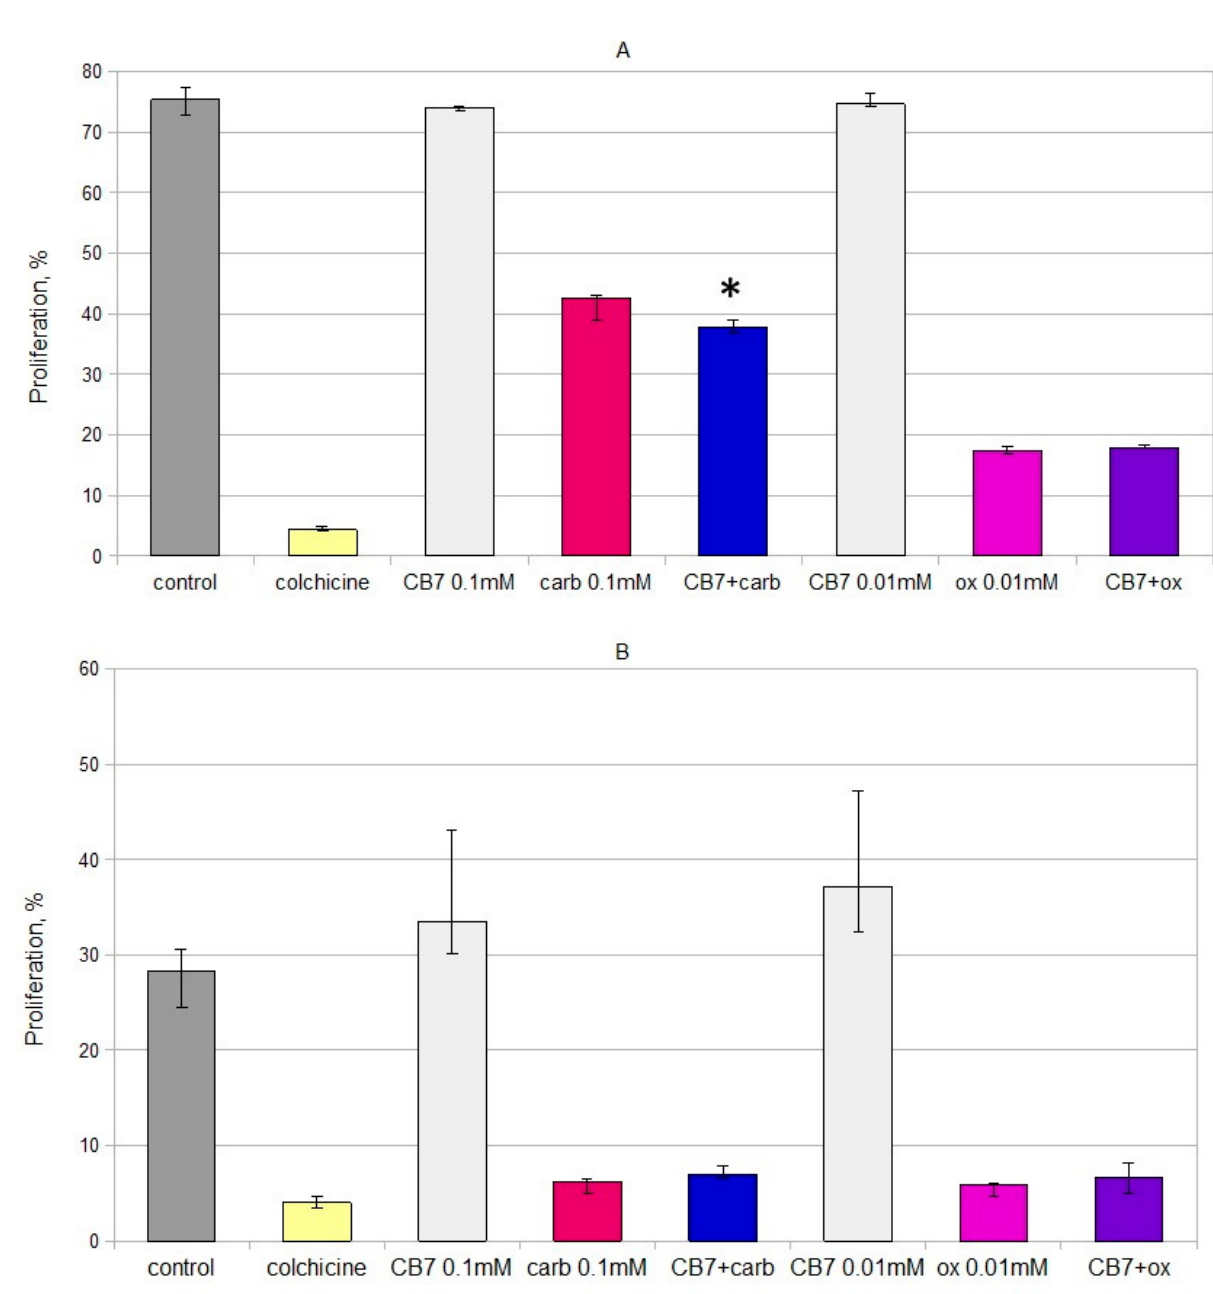
Figure 3. Effects of the CB[7] and platinum drugs on proliferation activity of different cell line. ( A ) Effects of the oxaliplatin–CB[7] complex and the mixture of CB7 and carboplatin (1:1) on proliferation of B16 cells. * Indicates a significant difference ( p < 0.05) vs. carboplatin. ( B ) Effects of the oxaliplatin–CB[7] complex and the mixture of CB7 and carboplatin (1:1) on proliferation of K562 cells. Abbreviations: carb—carboplatin; ox—oxaliplatin. Data are expressed as the median with interquartile range.